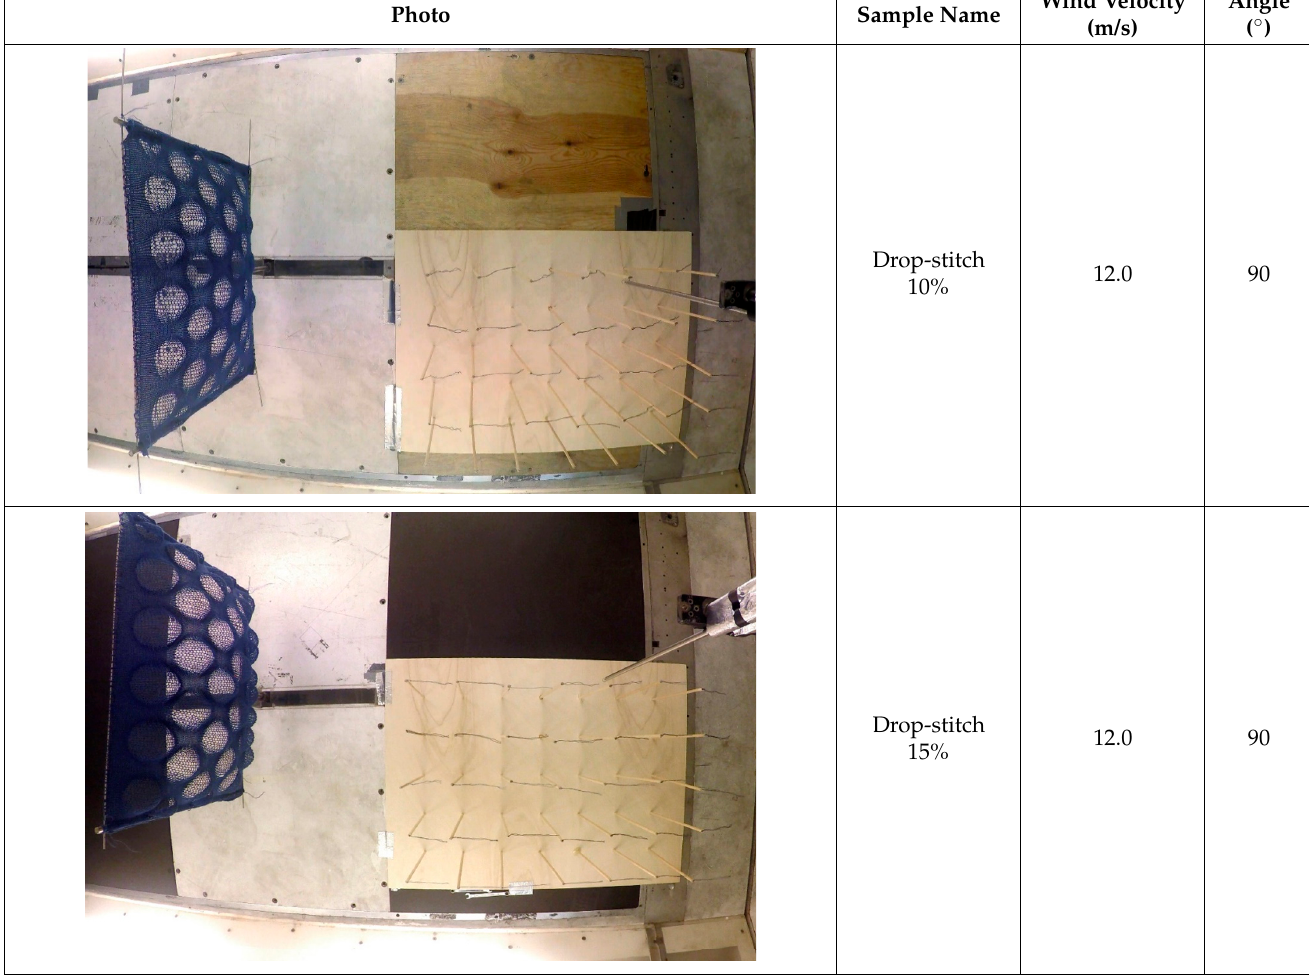
Figure 20. Drag coefficient, C d , for the models at 90 ◦ , with each curve representing a wind velocity. Table 3. Comparing deformation and wind pattern behind the prototype for all test at a wind velocity of ~12 m/s at 90 ◦ . Photo